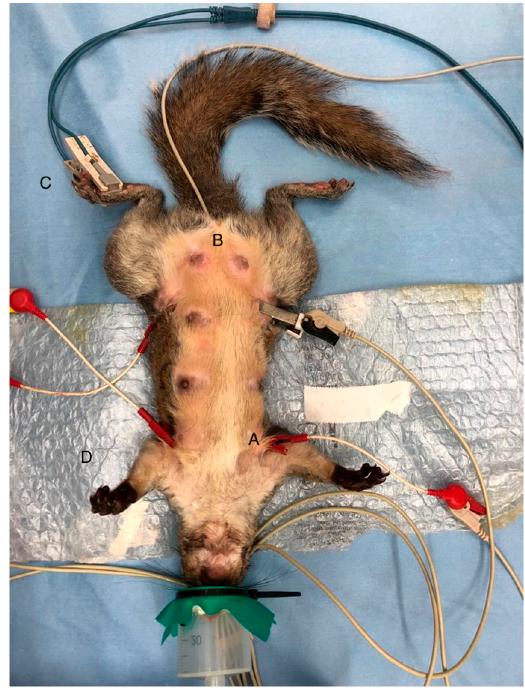
Figure 4. Female gray squirrel placed on the surgical table instrumented with monitoring for vital parameters such as the electrocardiogram ( A ), rectal temperature probe ( B ), and pulse oximeter ( C ), wrapped with a bubble wrap packaging material ( D ).